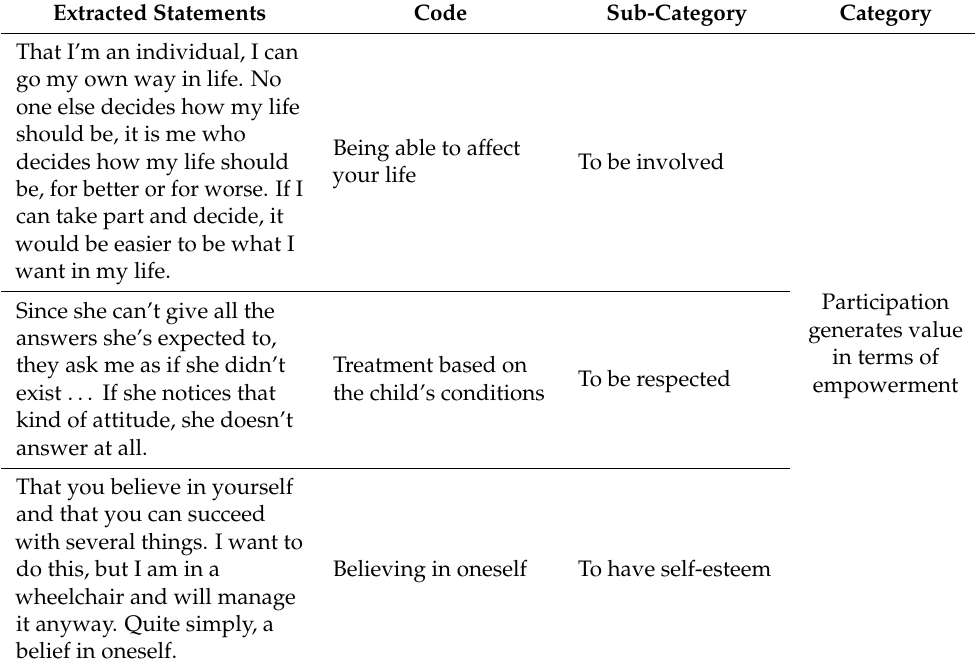
Table 2. Example of how the analysis was